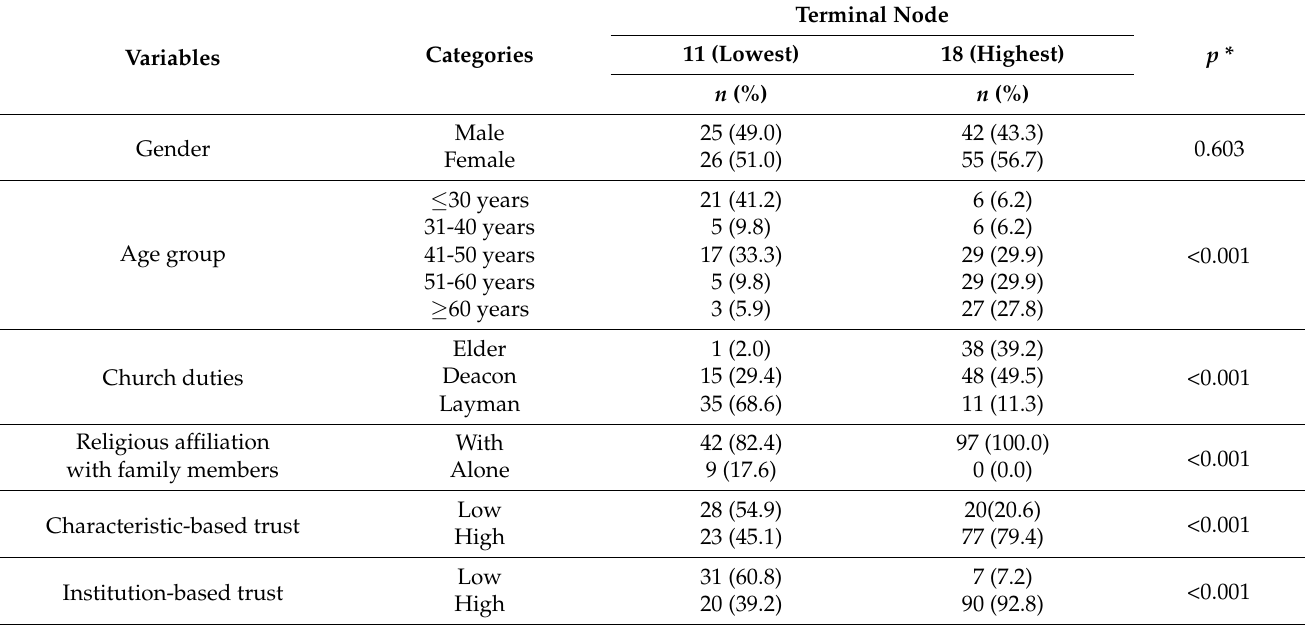
Table 2. Difference between the highest and lowest spiritual experience score terminal node ( n =